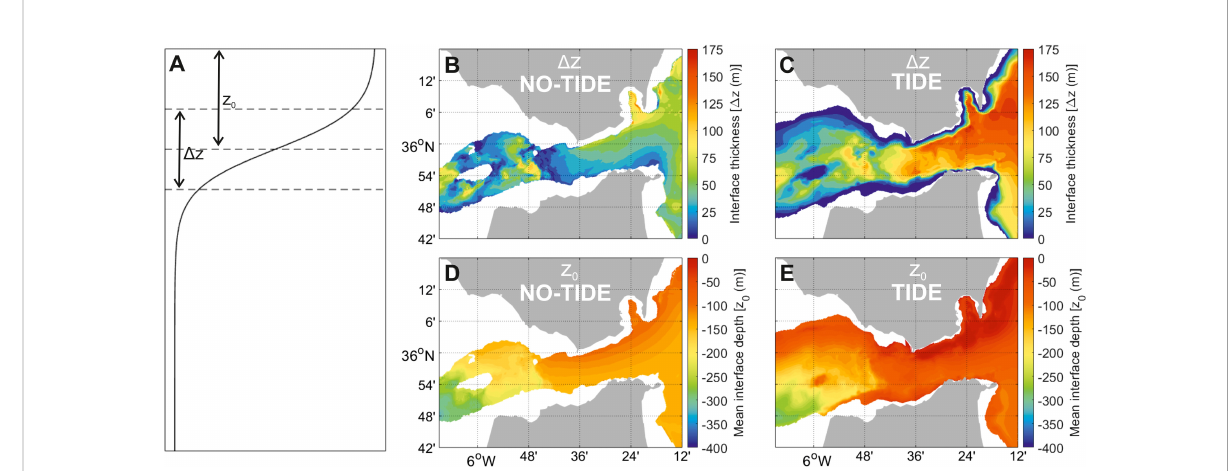
FIGURE 6 (A) Representation of the interface mixing layer thickness ( D z) and depth (z 0 ) for an idealized density pro fi le. (B, C) Time-mean interface mixing layer thickness ( D z) in the SoG derived from a non-tidal and a tidal simulation, respectively. (D, E) Same as (B, C) for the interface mixing layer depth (z 0 ). Adapted from Naranjo et al.,